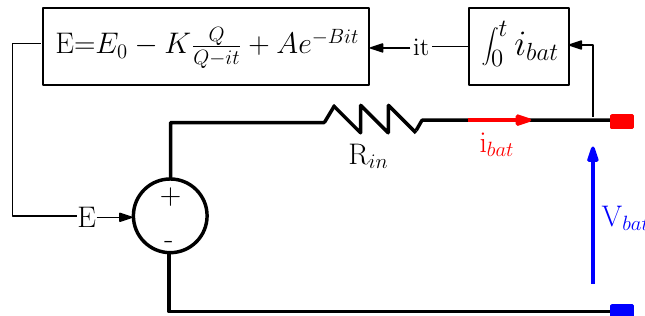
Figure 4. The generic battery